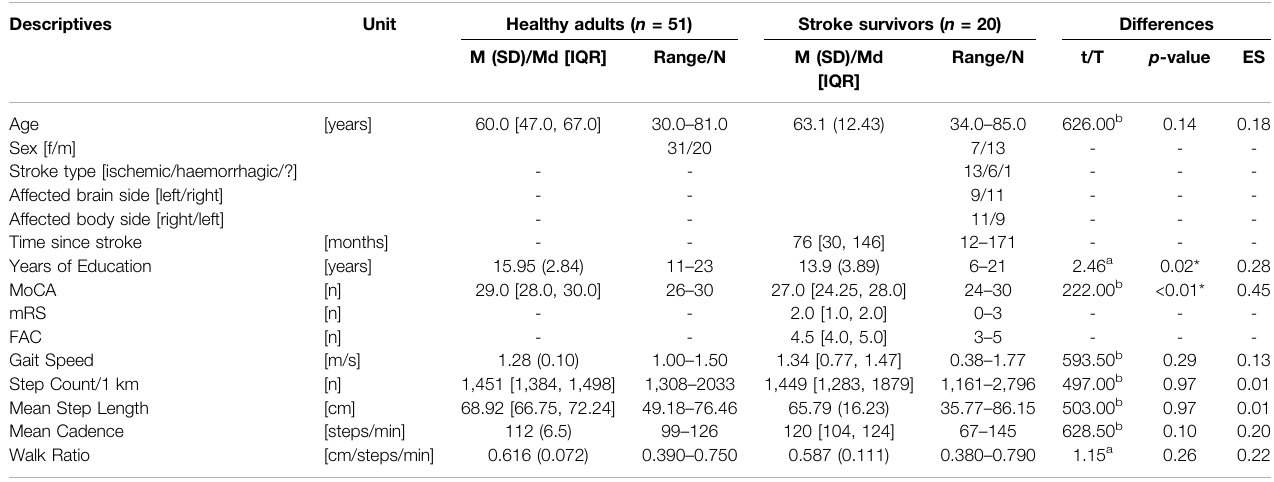
TABLE 1 | Descriptive characteristics.